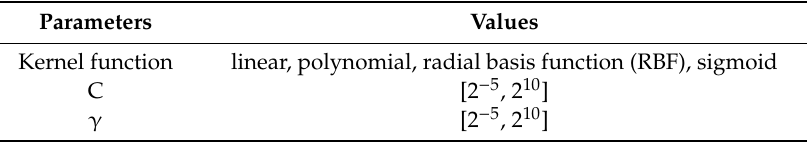
Table 4. Grid search values for Support Vector Machines